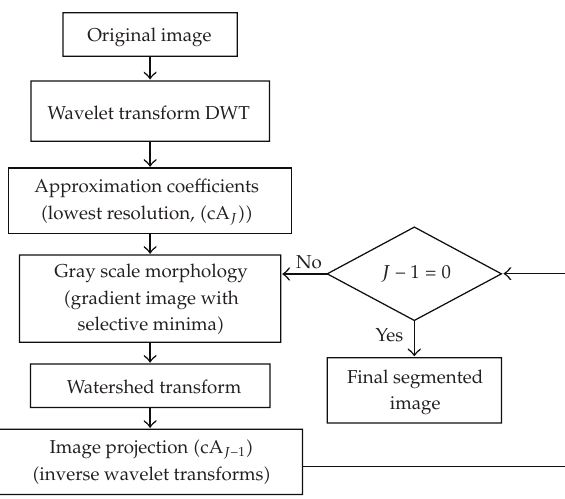
Figure 1: Flow chart of